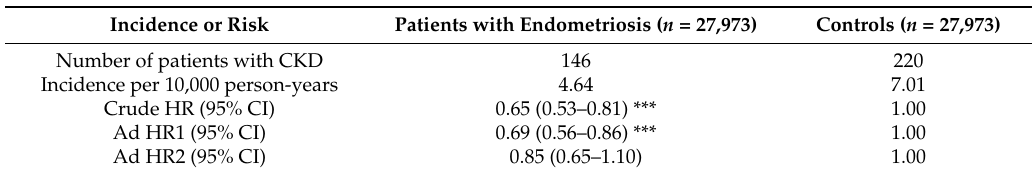
Table 2. Incidence and crude and adjusted risk of chronic kidney disease, according to endometriosis status.